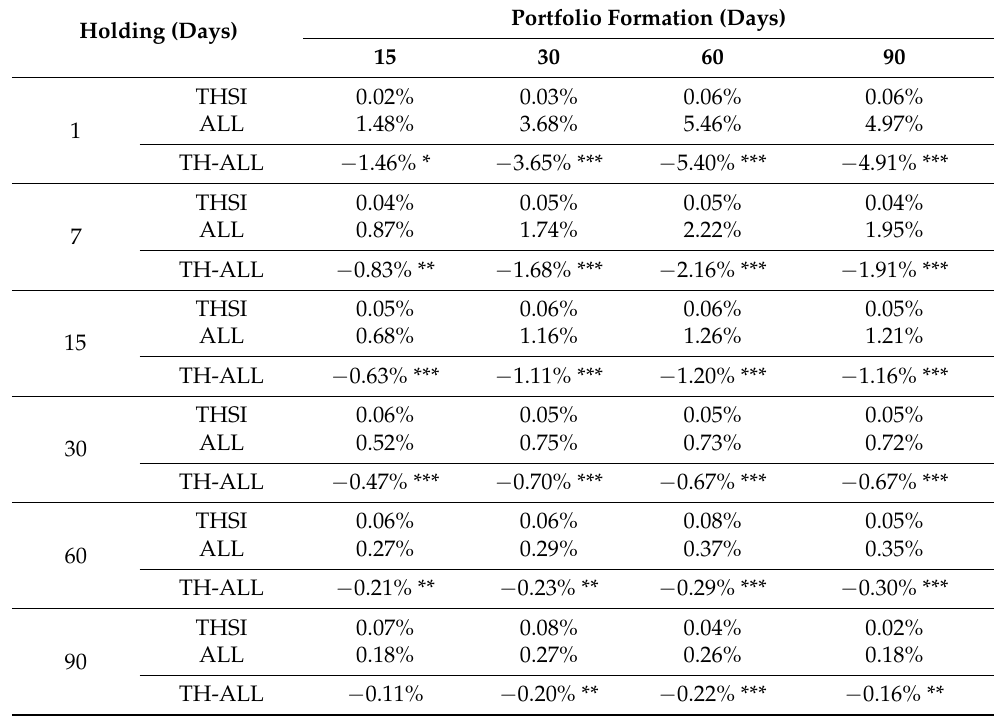
Table 3. A comparison of contrarian profits between THSI-listed and all SET-listed companies. Portfolio Formation (Days) Holding (Days) 15 30 60 90 THSI 0.02% 0.03% 0.06% 0.06% ALL 1.48% 3.68% 5.46% 4.97% 1 TH-ALL − 1.46%